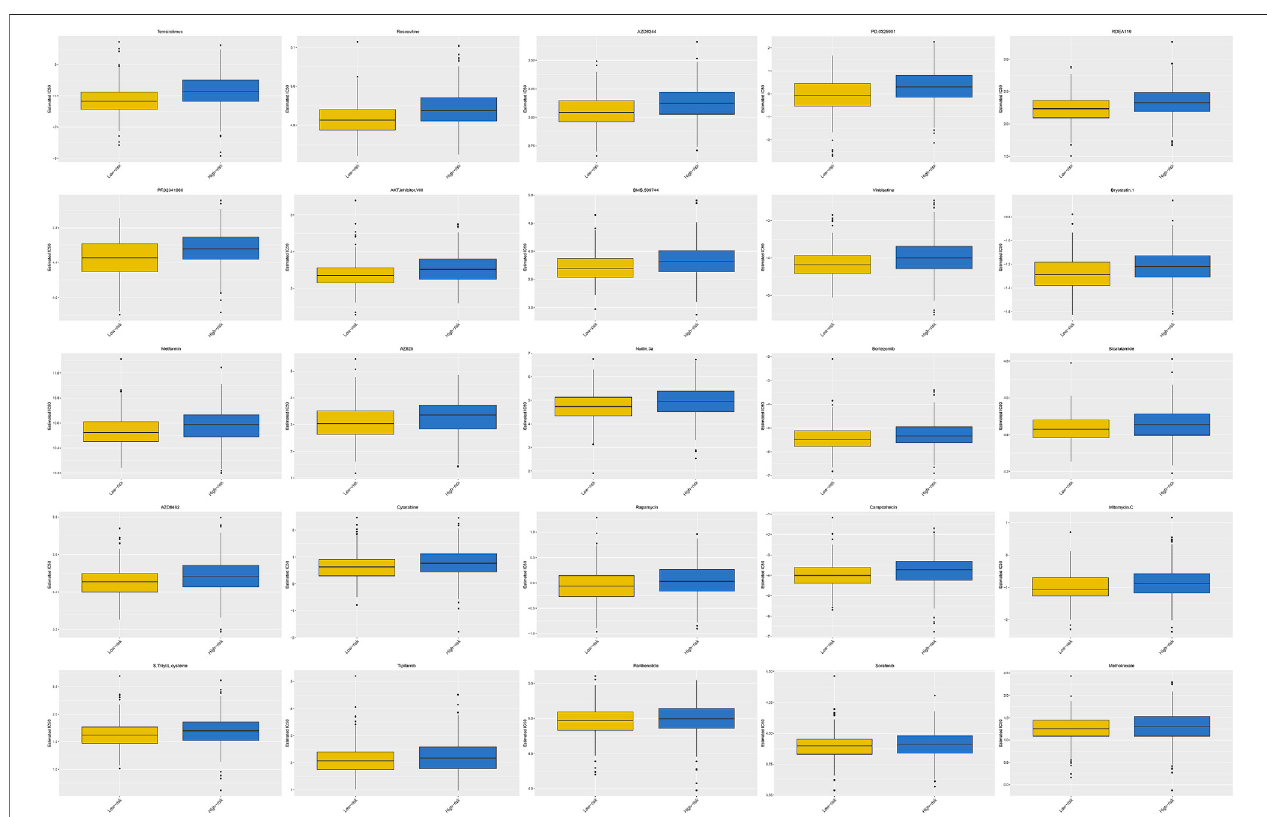
FIGURE10| Predictionoftheresponsetocommonchemotherapydrugsbetweenthelow-andhigh-riskgroups.Patientsinthehigh-riskgrouppossessedhigher estimated IC50 than patients in the low-risk group. In the high-risk group, N (cid:1) 267; in the low-risk group, N (cid:1) 244.